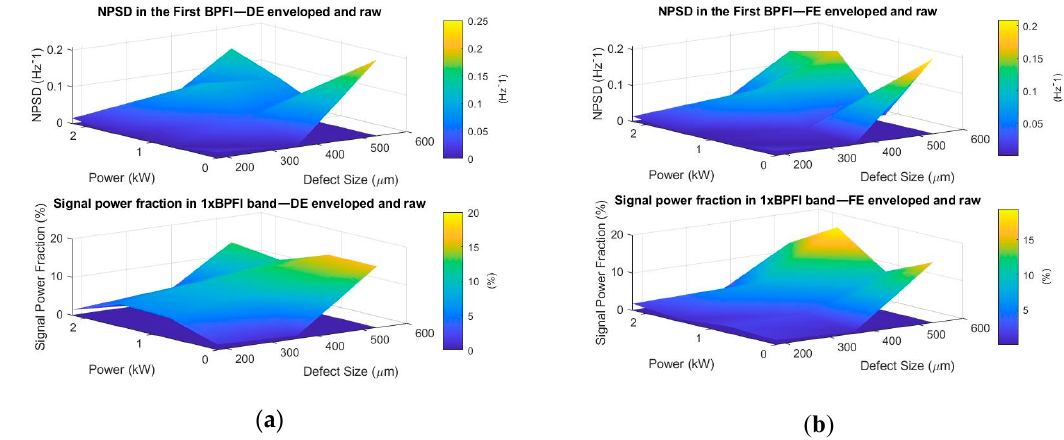
Figure 19. NPSD and HI for the enveloped and nonenveloped vibration signals. ( a ) DE and ( b ) FE.